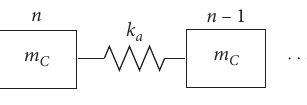
Figure 5: MS car-following